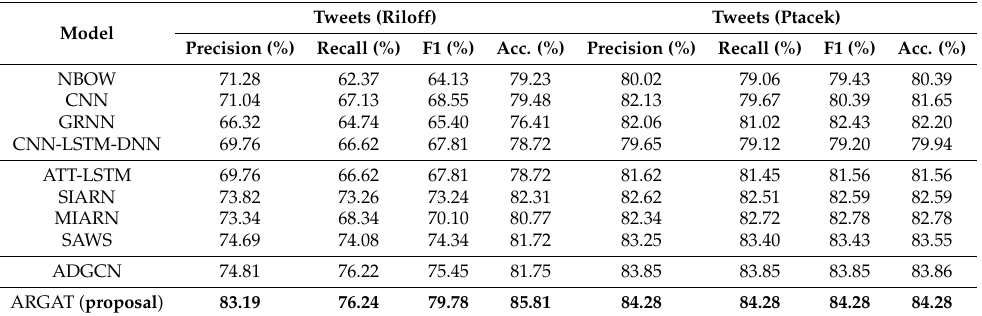
Table 3. Experimental results on Tweets datasets. The best results are in bold and the results of four basic models are from